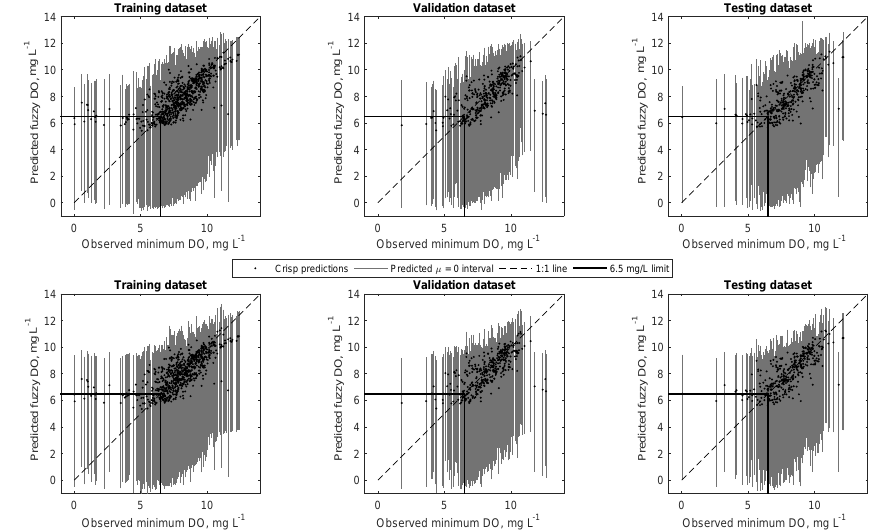
Figure 6. A comparison of the predicted and observed minimum DO at the µ = 0 interval (grey line) and at µ = 1 (black dots) for the proposed (top row panels) and existing (bottom row panels)